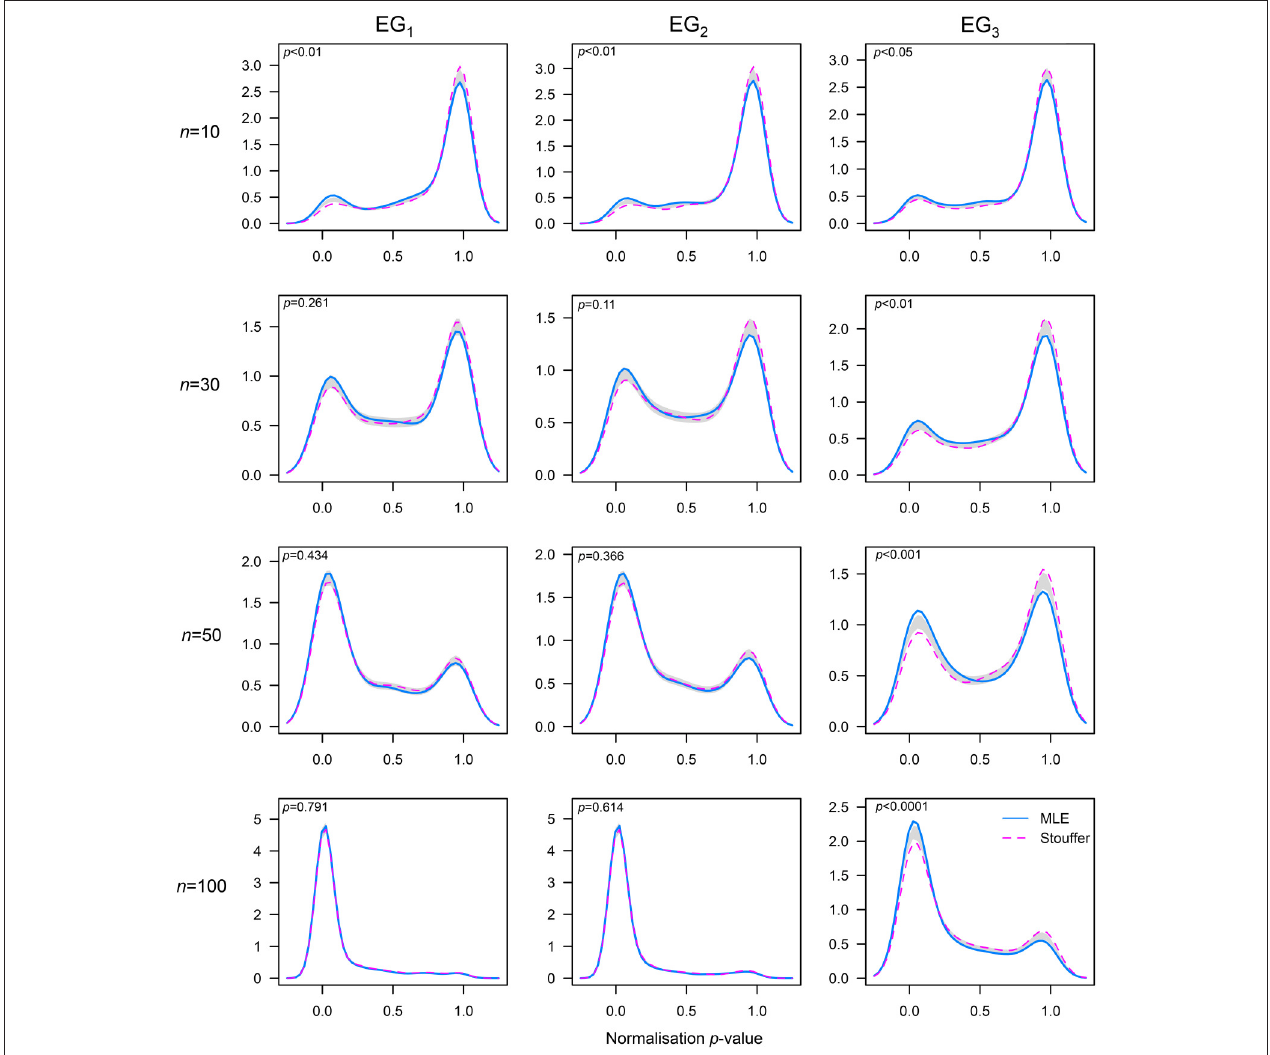
FIGURE 4 | Comparison of probability densities between the MLE and Stouffer–combined p -value approaches to estimate λ . A permutation test of equality with n boot = 1000 samples was utilized (see [48], for details). The x -axis represents the p -value obtained by combining six normality tests using the Stouffer’s method; the support of the p -values is the interval (0 , 1) . Results for the sample sizes n = 10 , 30 , 50 , and 100 are shown by row. The gray band represents the 95% CI for the difference between